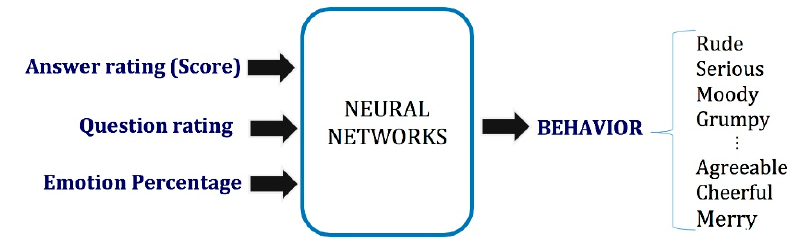
Figure 10. Representation of the input and output data for the selection of twenty different behaviors.